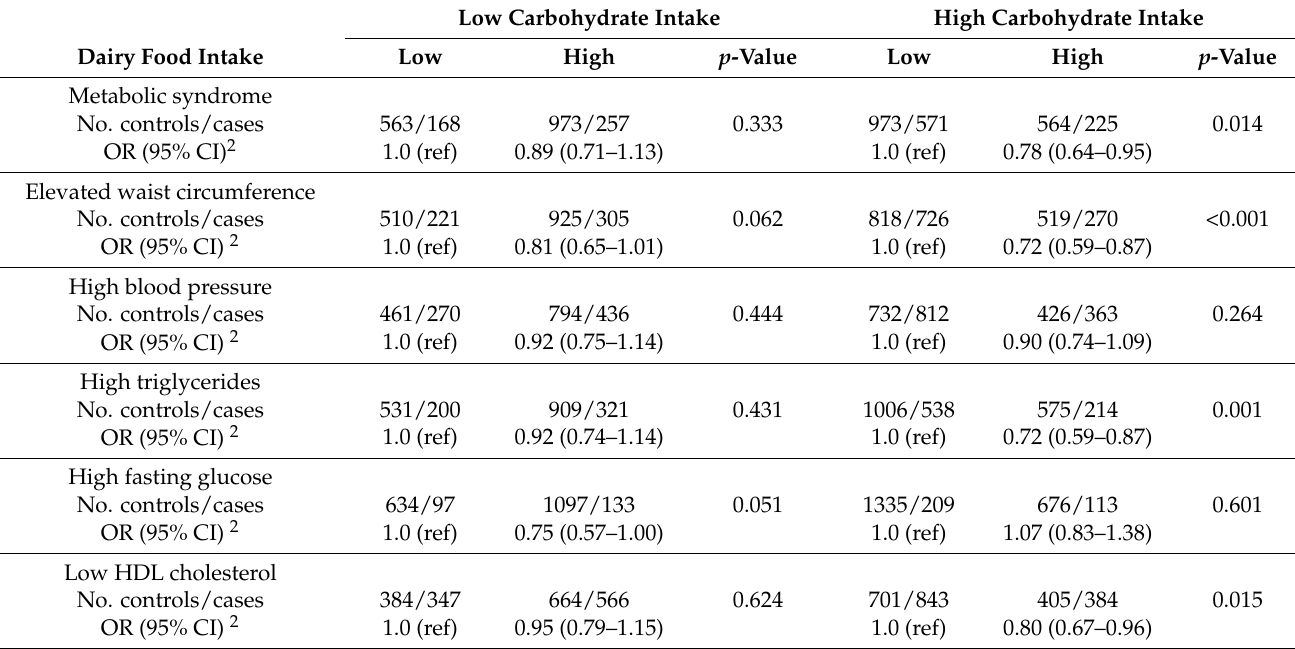
Table 4. Association between dairy food intake and the risk of metabolic syndrome and its components, stratified by the level of carbohydrate intake 1